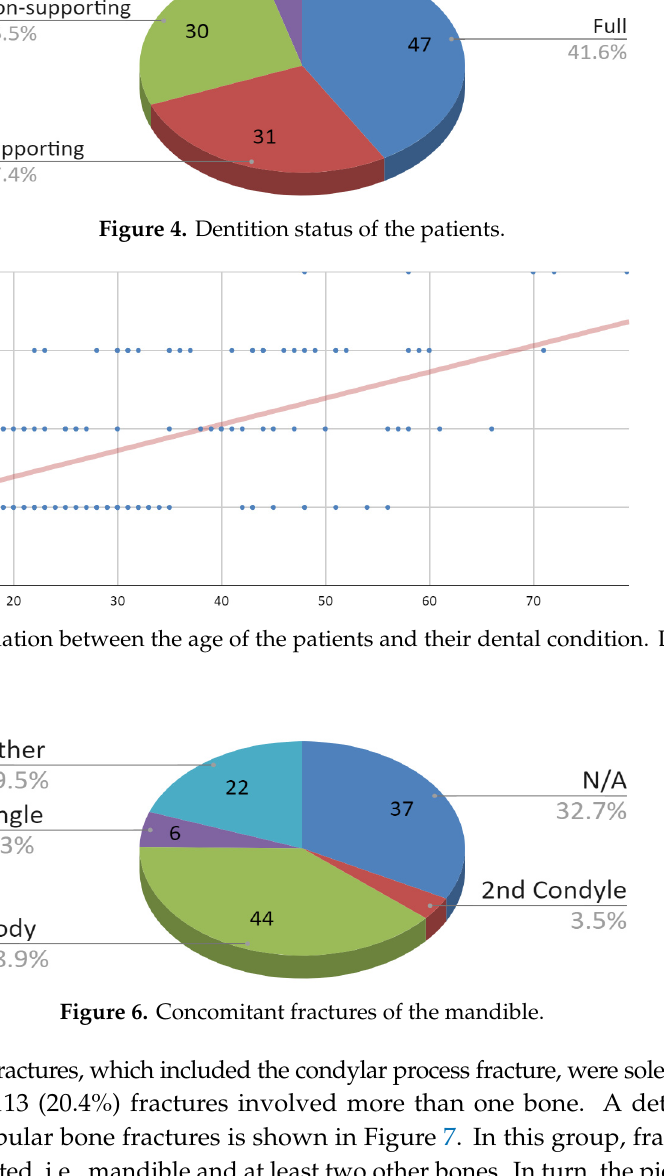
Figure 6. Concomitant fractures of the mandible.